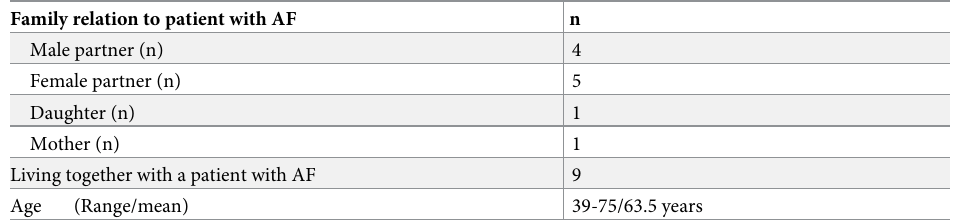
Table 1. Characteristics of family